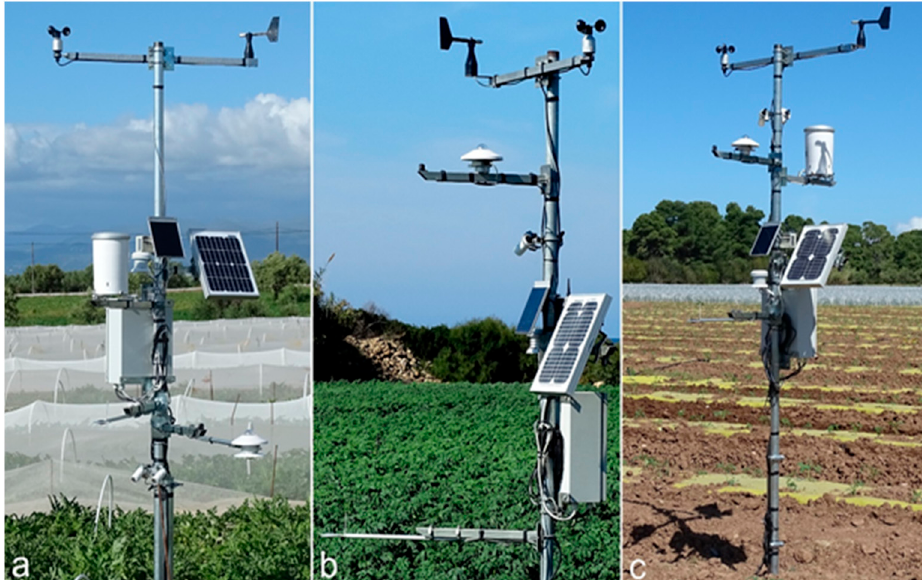
Figure 5. Three stations were installed in the middle of the experimental fields: ( a ) the first station in field 1, with early watermelon cultivation with a plastic cover for protection against the spring frost; ( b ) the second station in field 2 with the cultivation of spring potato in the middle growing stage; ( c ) the third station installed in field 3 with young tomato plants.